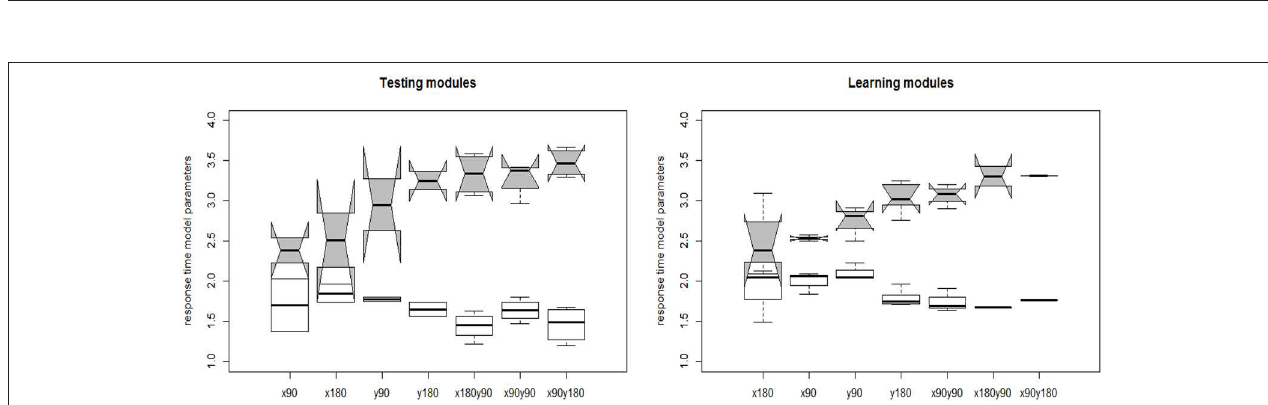
Frontiers in Psychology |